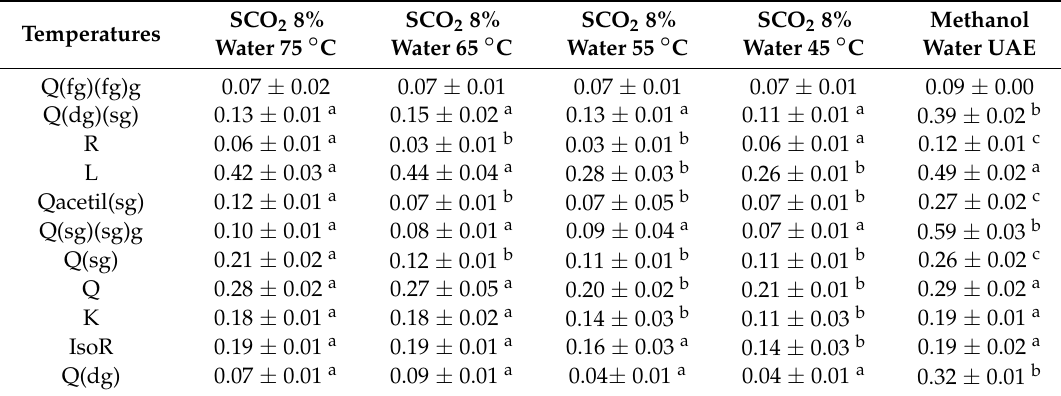
Table 4. Phenol composition (mg/g) of Eruca sativa extract obtained by SCO 2 at different temperatures. Temperatures